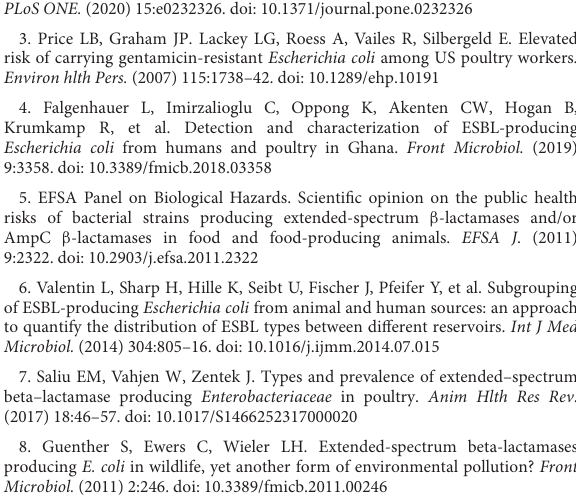
SUPPLEMENTARYFIGURE6 Summary of main chain parameters for the modeled SHV-228 protein structure. SUPPLEMENTARYFIGURE7 Summary of side chain parameters for the modeled SHV-228 protein structure. SUPPLEMENTARYFIGURE8 RMSD profile for the modeled SHV-228 protein structure. SUPPLEMENTARYFIGURE9 Surface view of macromolecules. (A) TEM-1 (in ruby color) showing the opening of the catalytic pocket marked in yellow color. (B) CTX-M-15 (in cyan color) showing the opening of the catalytic pocket marked in yellow color. (C) SHV (in gray color) showing the opening of the catalytic pocket marked in yellow